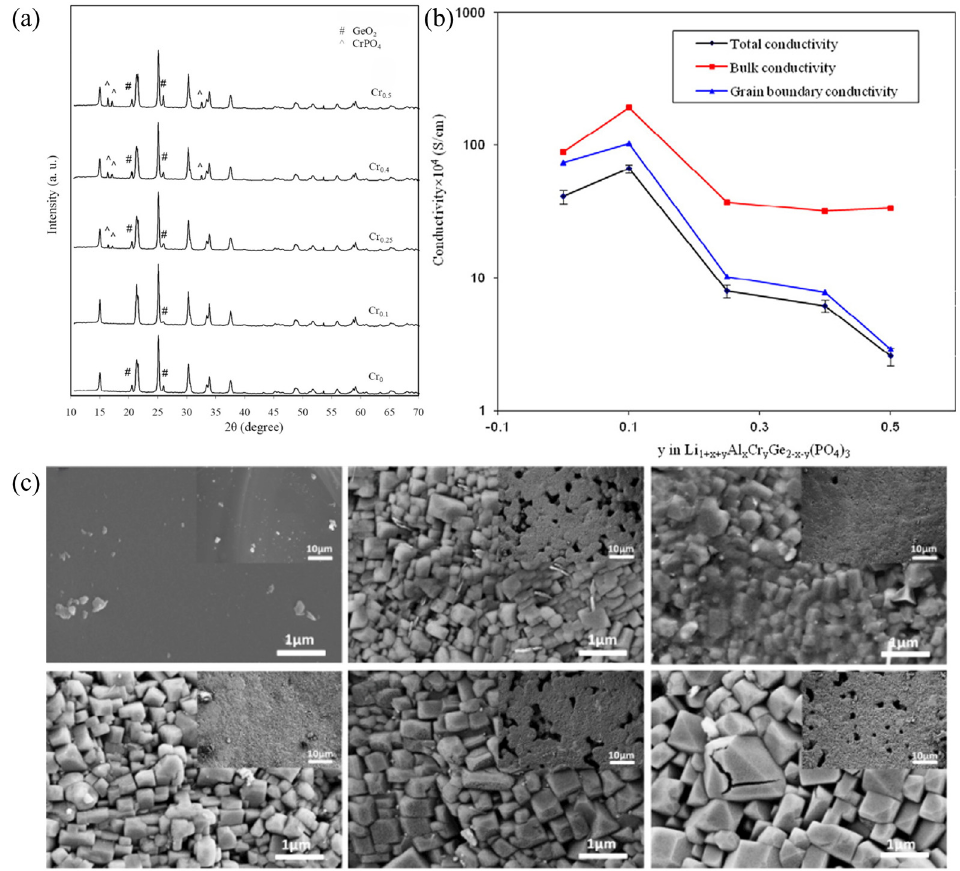
Figure 3. ( a ) XRD patterns of samples with different Cr contents crystallized at 850 ◦ C for 8 h; ( b ) The total, bulk and grain boundary conductivities measured at 26 ◦ C for Li 1+x+y Al x Cr y Ge 2 − x − y (PO 4 ) 3 samples with di ff erent Cr contents. Reprinted with permission from ref. [51]. Copyright 2016 Elsevier. ( c ) SEM micrographs of LAGP samples in glass phase and crystallized at 750 °C, 775 °C, 800 °C, 825 °C, 850 °C. Reprinted with permission from ref. [52]. Copyright 2015 Elsevier.